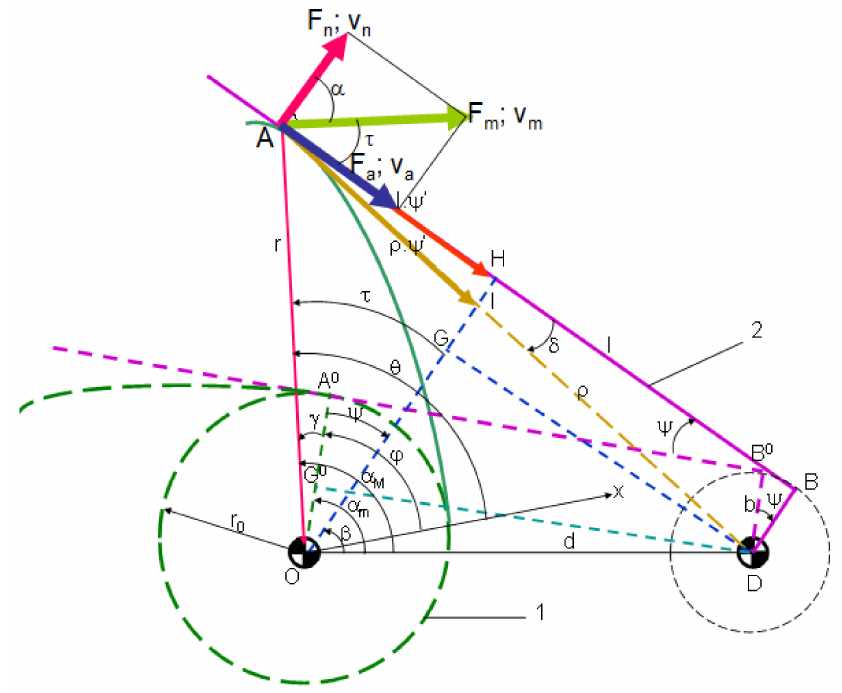
Figure 9. Forces and velocities to a mechanism with rotating cam and rotating adept (flat rocker).